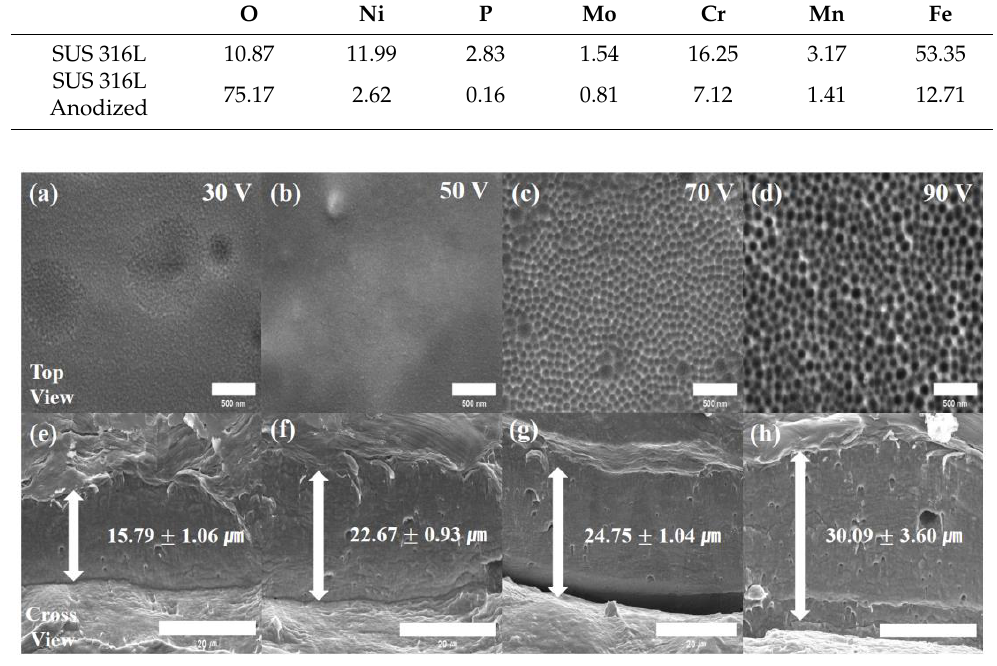
Figure 3. SEM images of oxide films on the surface after anodization for each voltage, at a treatment time of 3 h: top view at ( a ) 30 V, ( b ) 50 V, ( c ) 70 V, and ( d ) 90 V (scale bar: 500 nm); cross view at ( e )